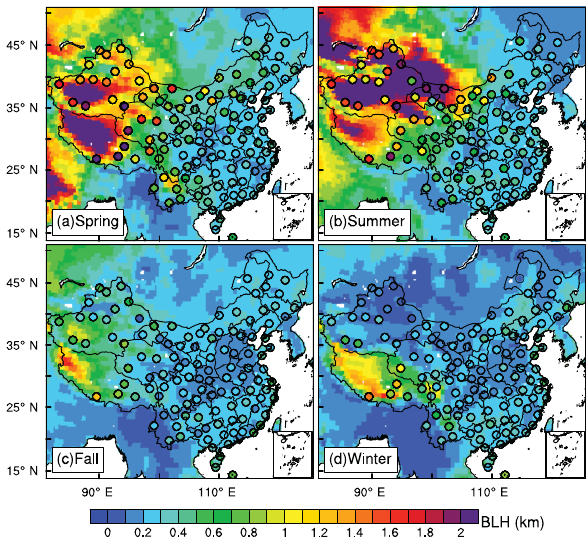
Figure 10. Same as in Fig. 7, but for the spatial distribution of BLHs at 02:00BJT. Note that only the stations that have more than 30 soundings are plotted in (b)